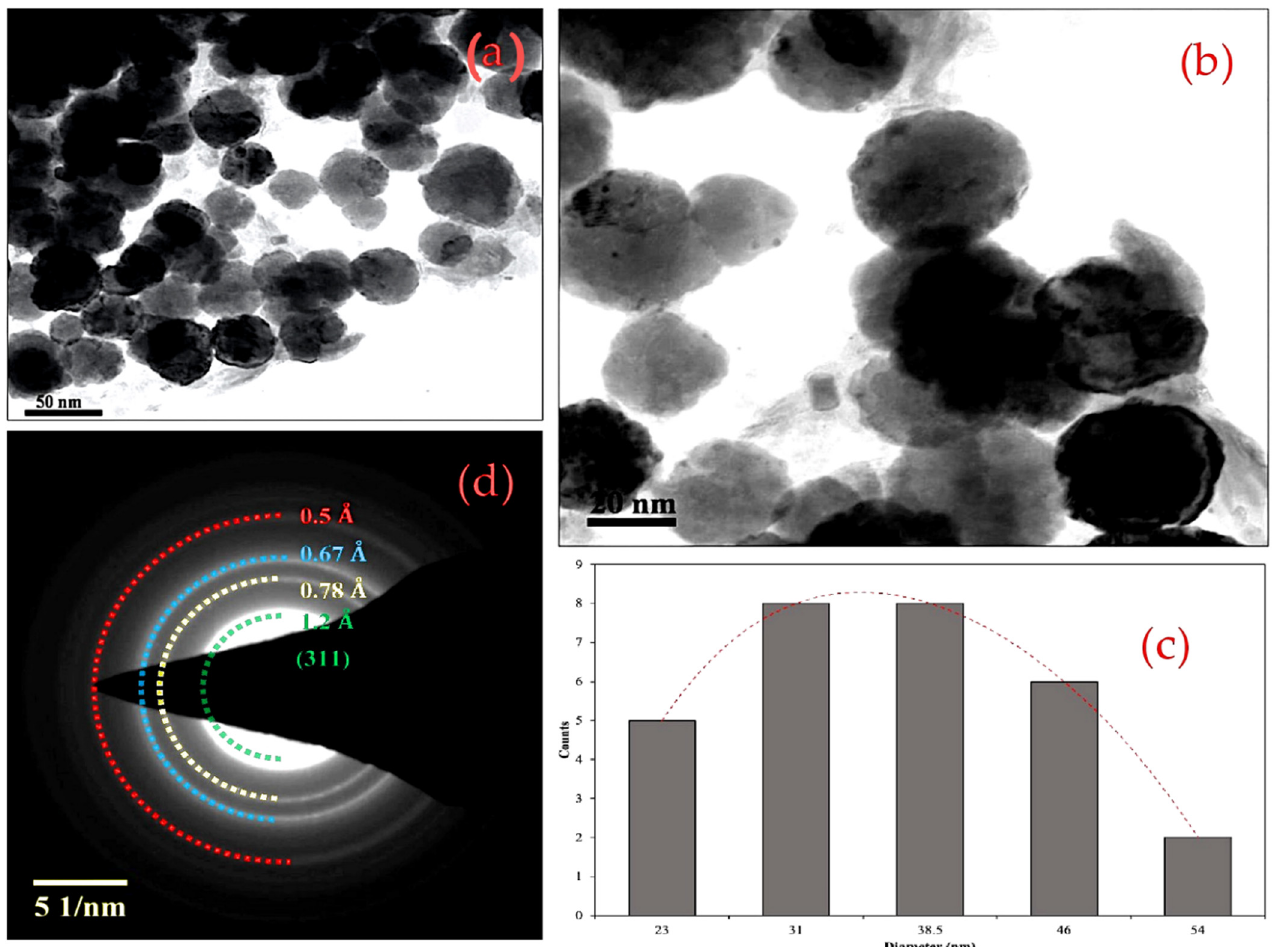
Figure 3. TEM micrographs: ( a ) 50 nm, ( b ) 20 nm, ( c ) particle size histogram, and ( d ) SAED pattern of AC-AgNPs.